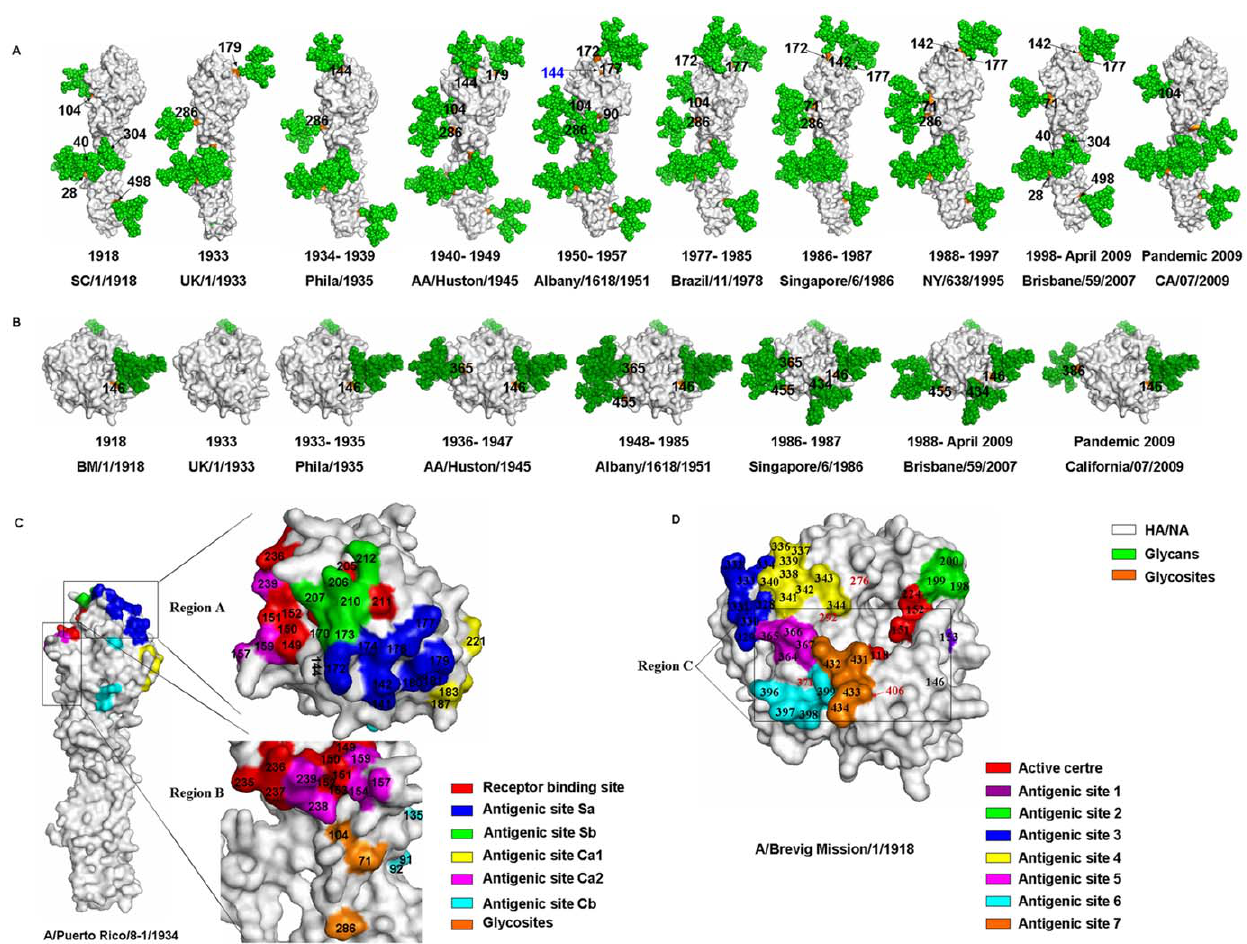
Figure 1. Structural overviews of the HA and NA monomers for human influenza H1N1 viruses. Each represented a unique glycosylation site pattern on HA or NA. (A) The monomers of HA with glycans attached at the potential glycosylation sites for representative human influenza H1N1 viruses from 1918 to 2010. (B) The monomers of NA with glycans attached at the potential glycosylation sites for representative human influenza H1N1 viruses from 1918 to 2010. (C) A monomer of HA with the location of the receptor-binding site (RBS) and the five antigenic sites [48,49]. Regions A and B are important regions with frequently altered glycosylation sites. (D) A monomer of NA with the location of the enzyme active site and the seven antigenic sites surrounding the enzyme active [40,50]. Region C is an important glycosylation region surrounding the enzyme active site. The amino acid locations are numbered according to the HA of SC 1918 and NA of BM 1918 numbering, respectively.